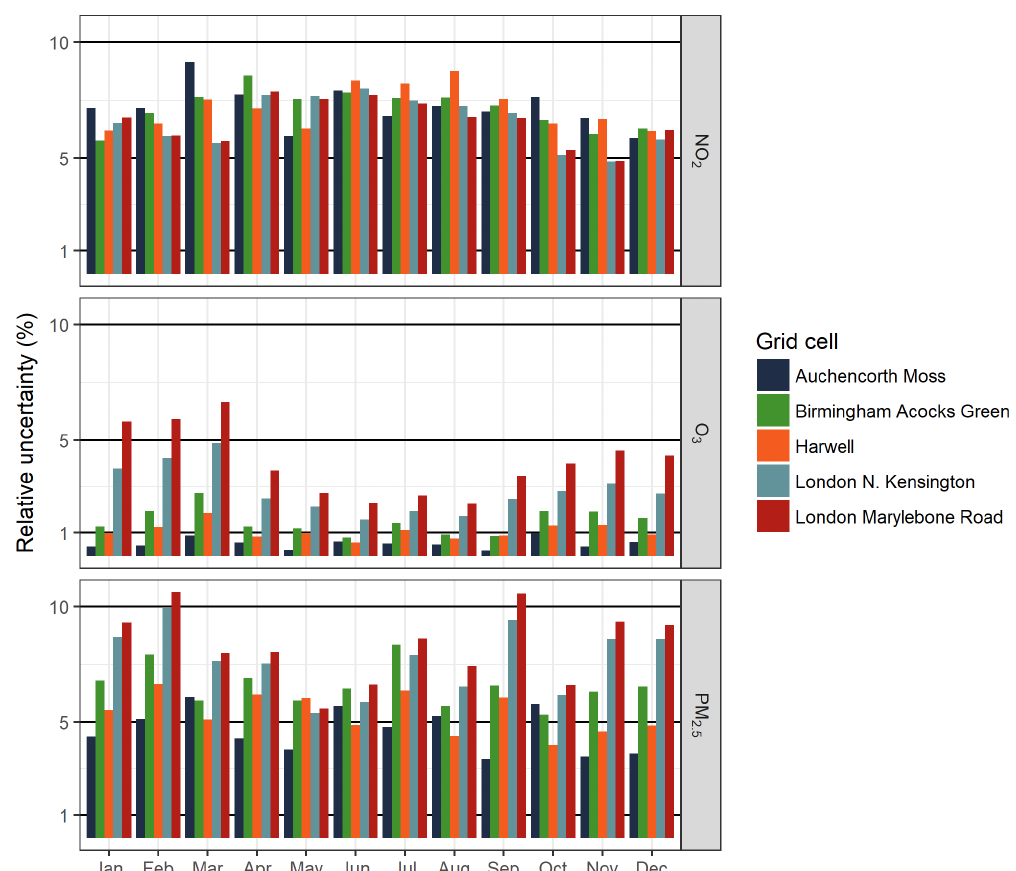
Figure 7. Magnitude of relative uncertainty in monthly average surface concentrations of NO 2 , O 3 , and PM 2 . 5 for five grid cells across the UK representing a spread of geographical locations and environment types. The environment types are assigned as follows: Auchencorth Moss and Harwell – rural background; Birmingham Acocks Green and London N. Kensington – urban background; and London Marylebone Road – urban